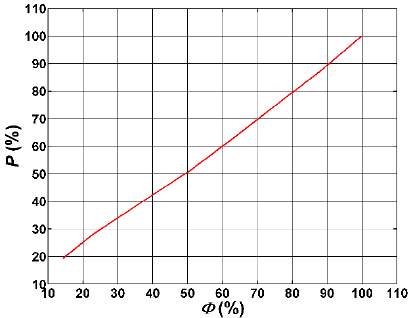
Figure 8. The relation of the active power of the luminaire P as a function of the luminous flux Φ .